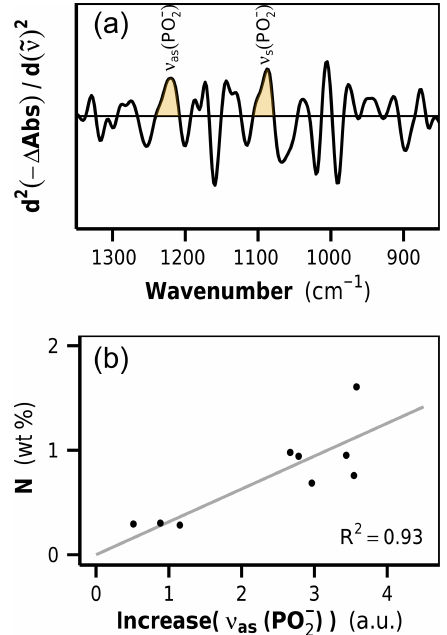
Figure 5. (a) Second-derivative difference spectra show positive bands at 1220 and 1090cm − 1 , identified as phosphodiester stretch- ing vibrations of DNA. The band height of the asymmetric phospho- diester band at 1220cm − 1 is used as a marker for increases in mi- crobial biomass content in litter. (b) Correlation between ν as (PO − increase and N content in decomposed rhizome litters. a.u.: arbitrary